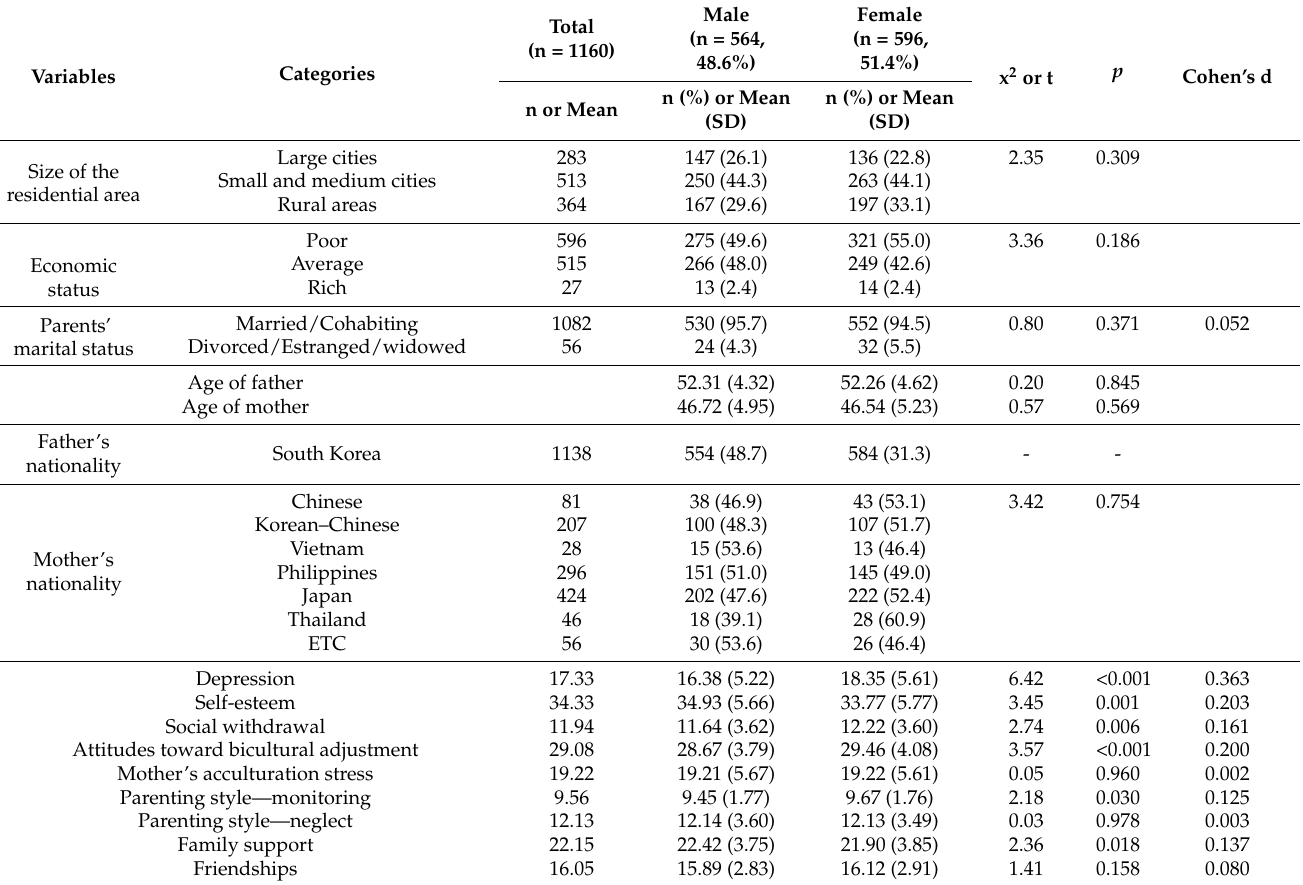
Table 1. Gender differences in the demographics of multicultural adolescents and their parents (n =